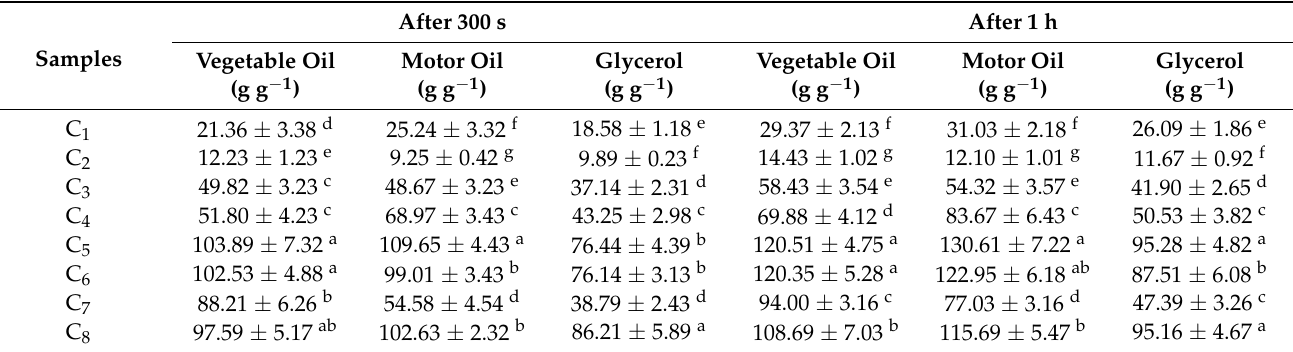
Table 3. Oil adsorption of the unmodified and modified CNC aerogels. After 300 s After 1 Samples